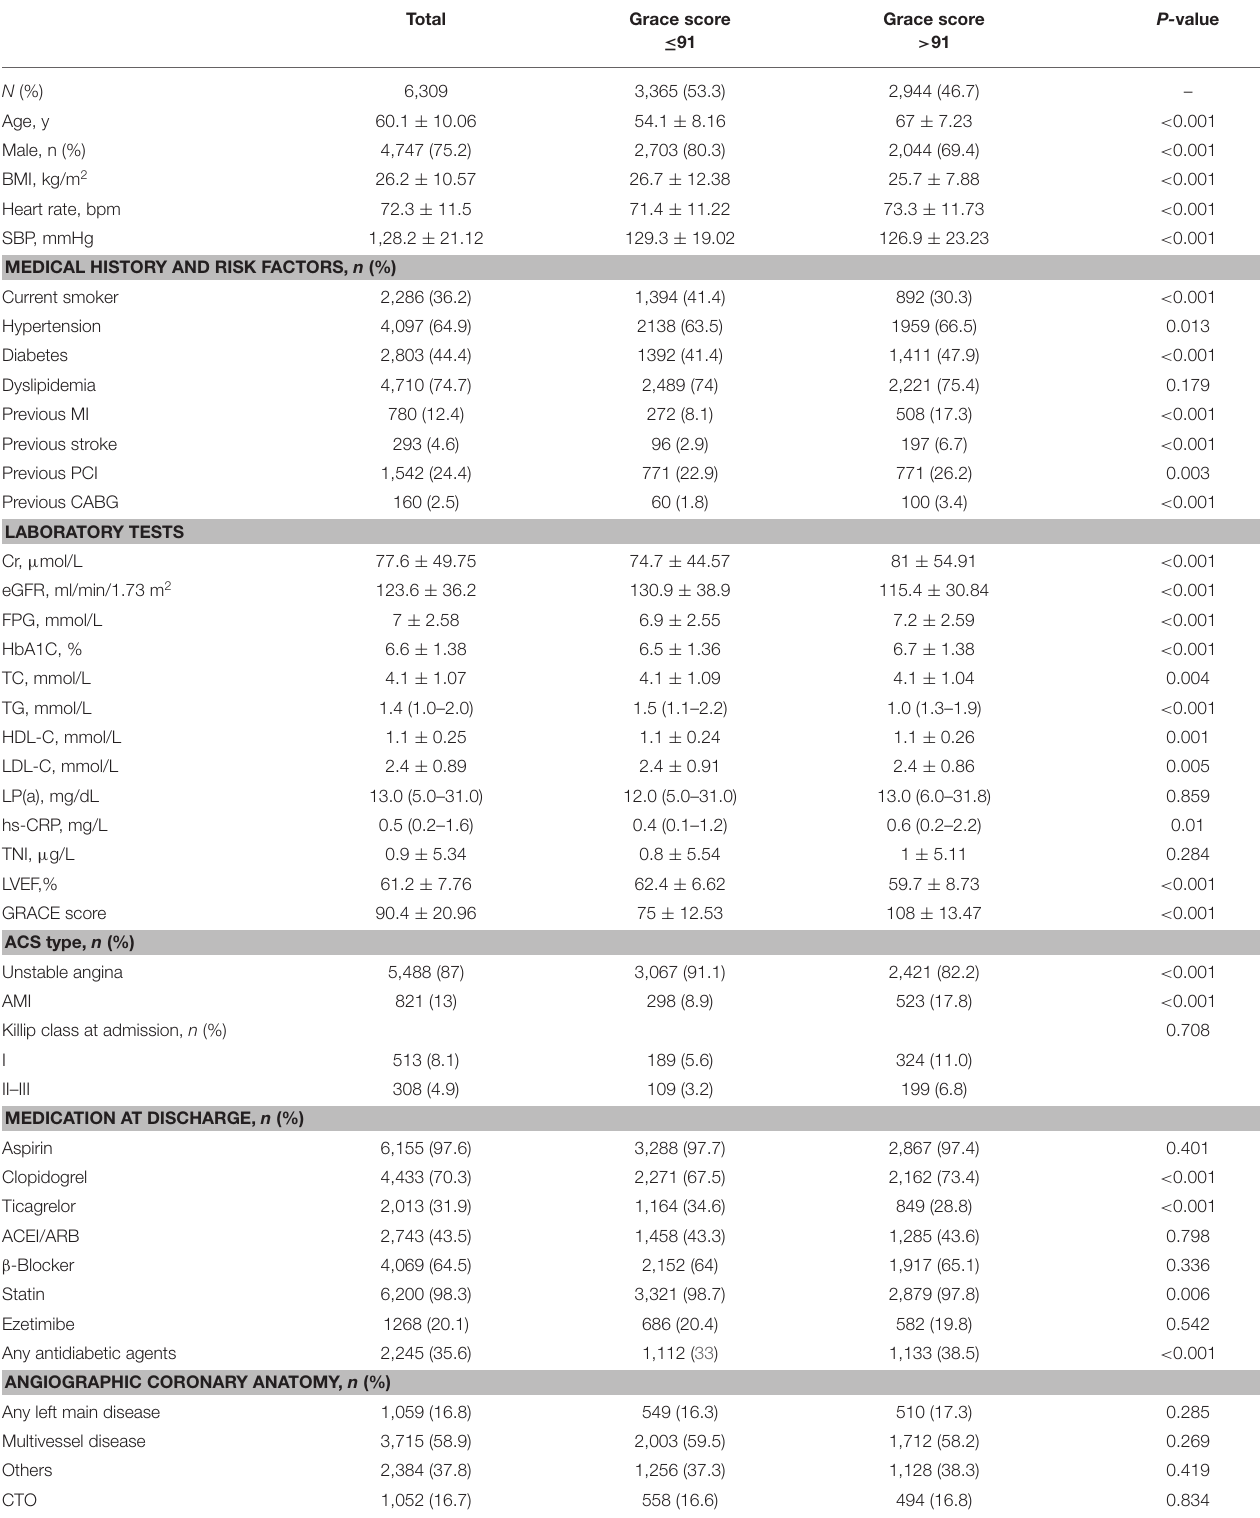
TABLE 1 | Baseline characteristics of patients according to GRACE